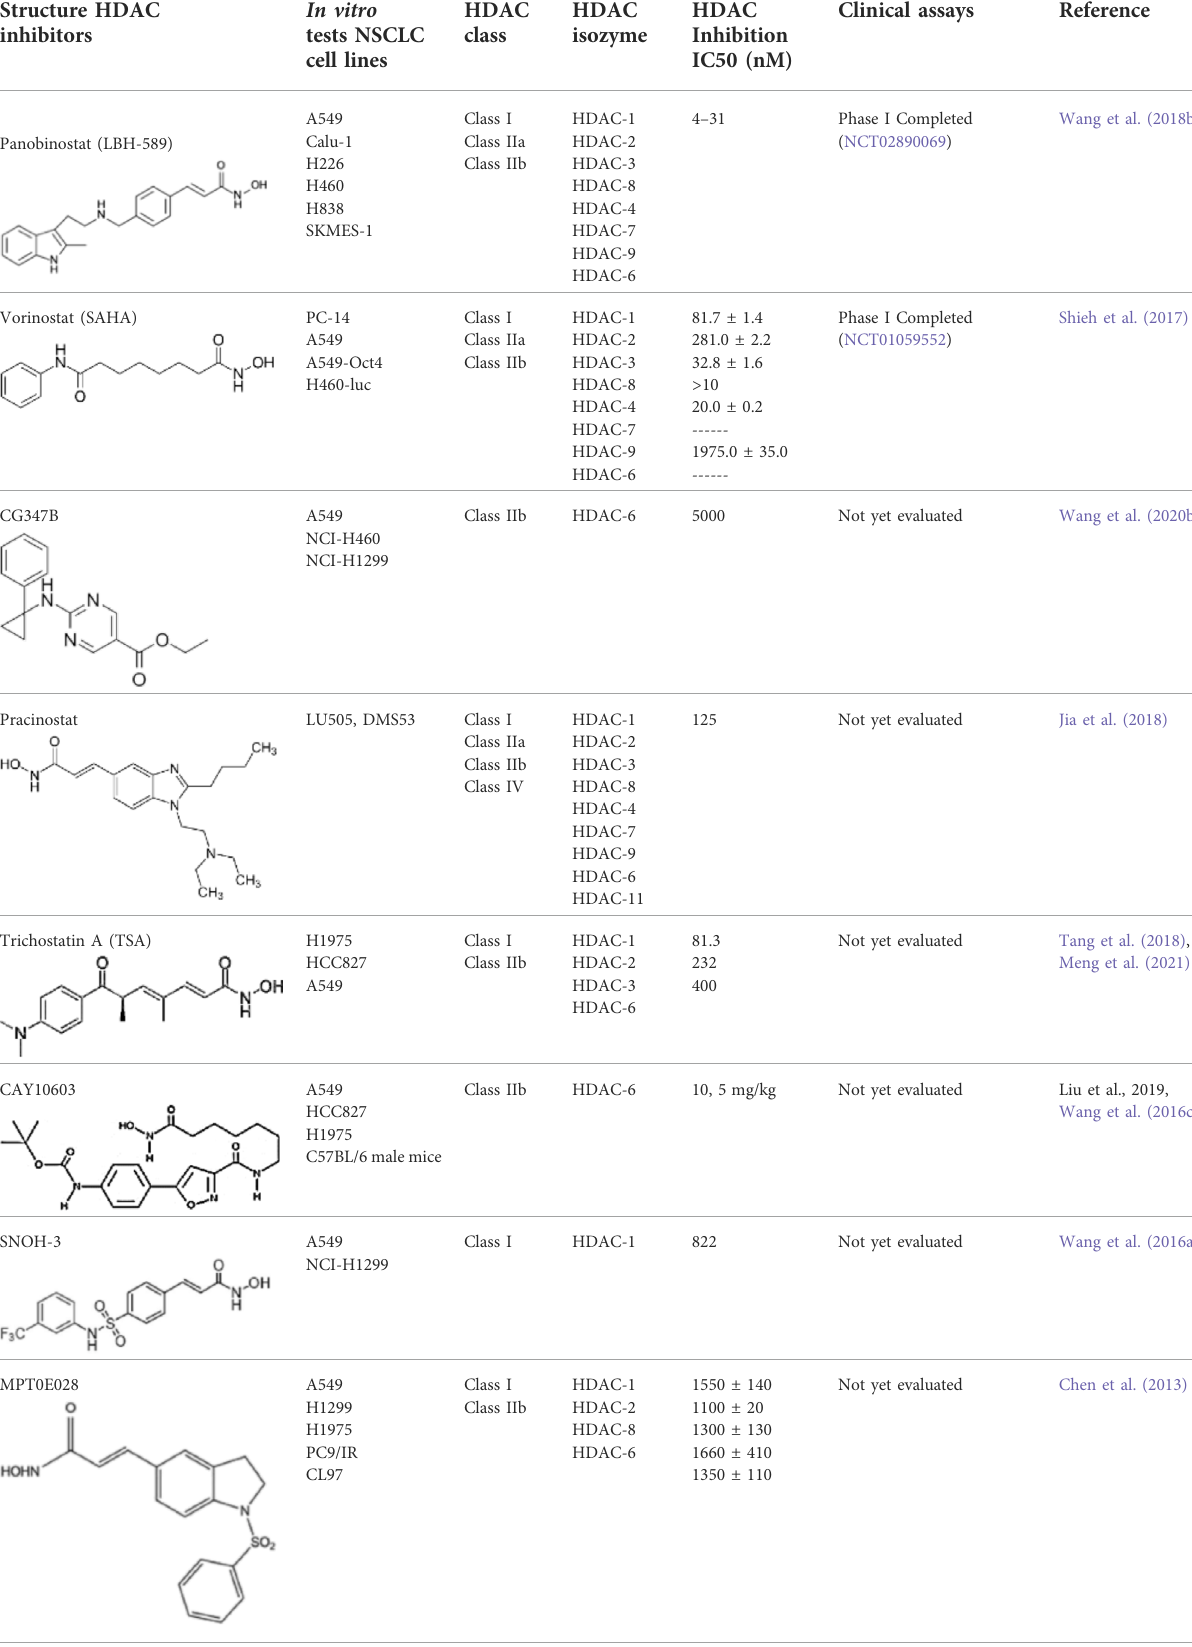
TABLE 2 Structure of HDACs inhibitors against deacetylase isozymes in lung cancer and clinical